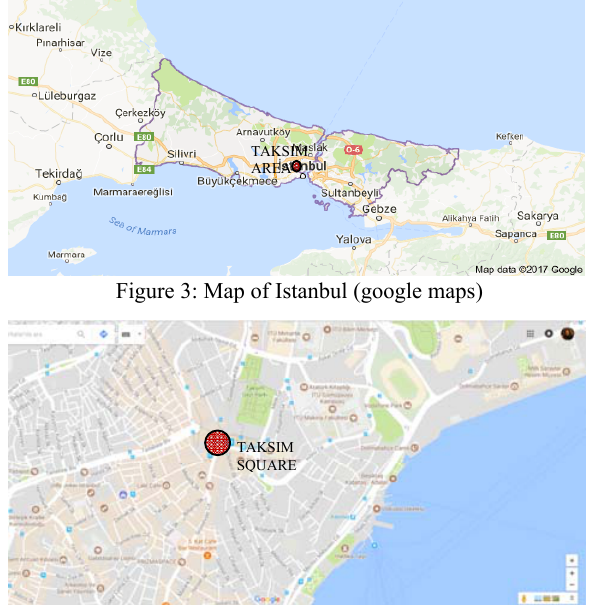
Figure 4: Map of Taksim area (google